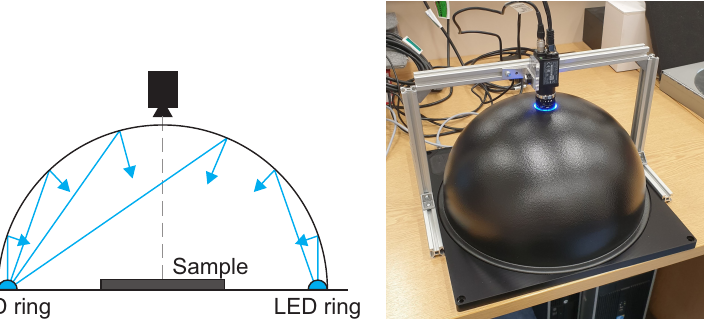
Figure 4. Dome illumination rig. ( Left ): Schematic showing some light rays from LED lights that result in full hemispherical illumination. ( Right ): Photograph of the capture rig including MBJ Imaging SDL-30-SDL-30 dome